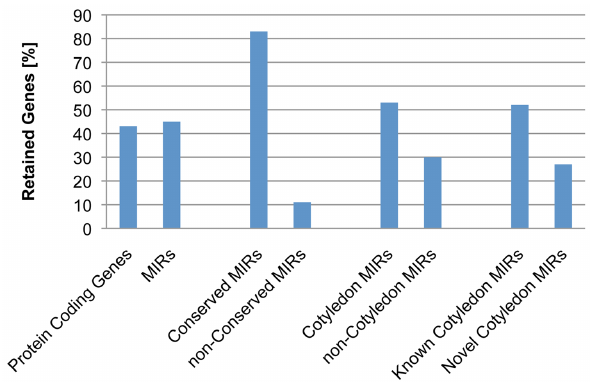
Figure 3. Retention of miRNAs on Recently Duplicated Soybean Genome Segments. The percentage of miRNA genes located on duplicated genome segments that are retained in their paired homologous genome segments from the Glycine whole genome duplication is shown on the Y-axis. Each category of miRNAs is indicated on the X-axis.